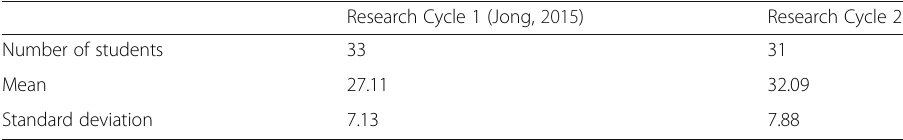
Table 5 Students ’ knowledge test results obtained in Research Cycles 1 and 2 at School